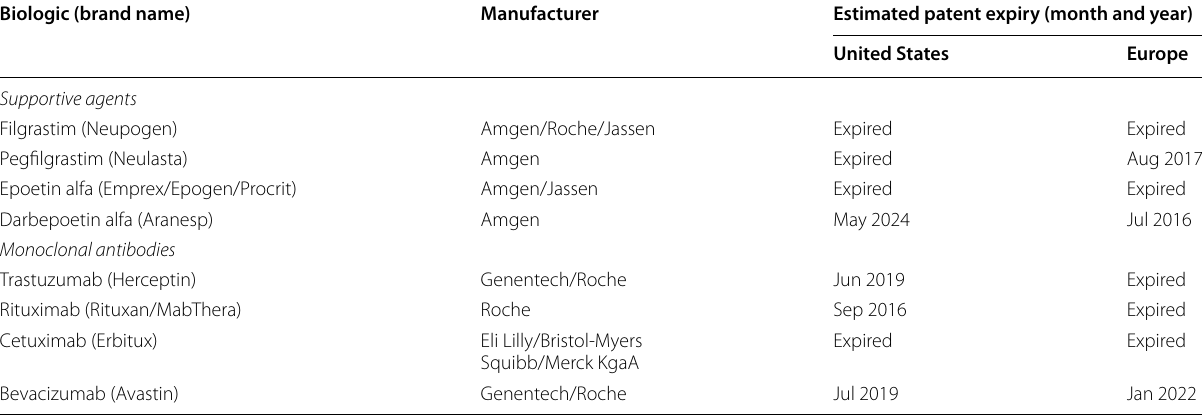
Table 1 Key oncological biologics whose patents either have expired or will expire soon Biologic (brand